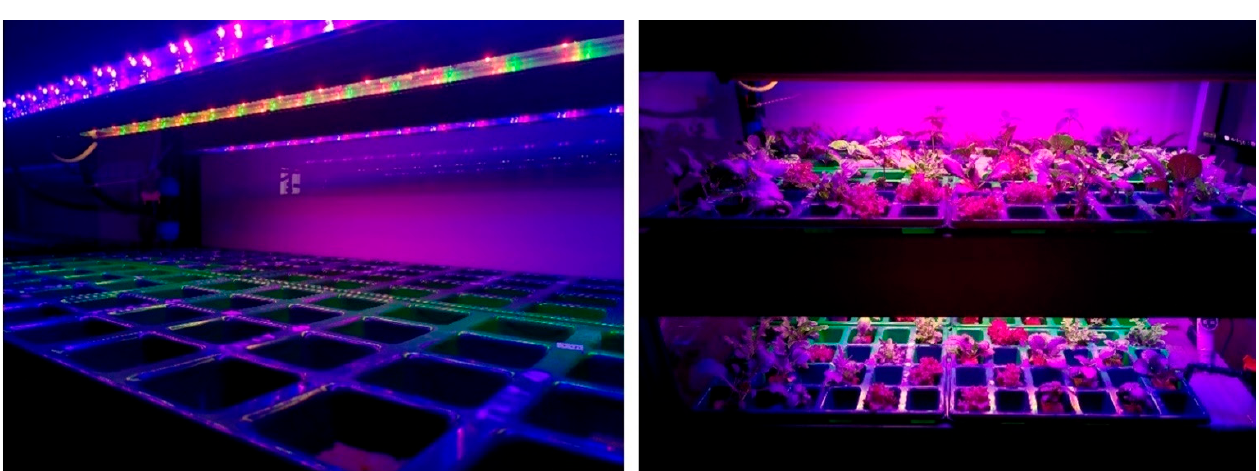
Figure 3. Monitoring unit, sensors for temperature, humidity, pH, EC and the irrigation control cabinet ( left ) and the user interface ( right ) (Photos: Cichocki 2020).